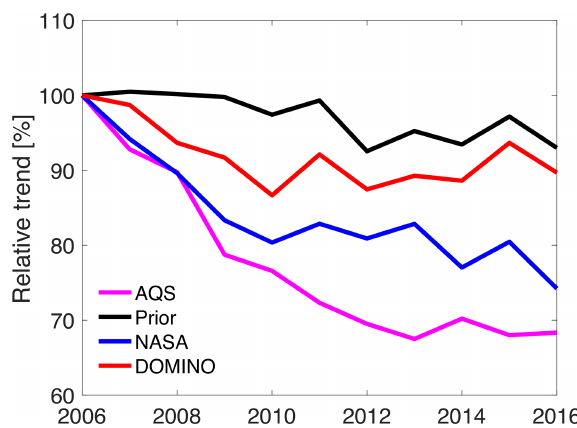
Figure 7. The trend of annual mean surface NO 2 concentrations over the US from 2006 to 2016, expressed as a percent of the 2006 values. Surface measurements are from EPA AQS sites (magenta line). GEOS-Chem simulations are performed using prior emissions (black line) with constant anthropogenic emissions throughout the years, posterior NO x emissions constrained by the NASA prod- uct (blue line), and posterior NO x emissions constrained by the DOMINO product (red